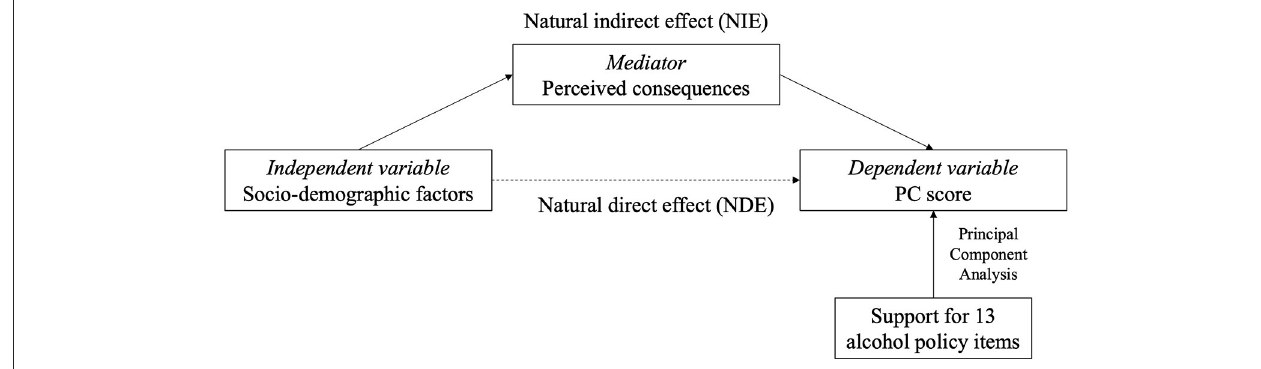
FIGURE 1 | Conceptual model. Indirect relationship of socio-demographic factors with policy support (measured by PC scores) through mediators (perceived consequences). PC, principal